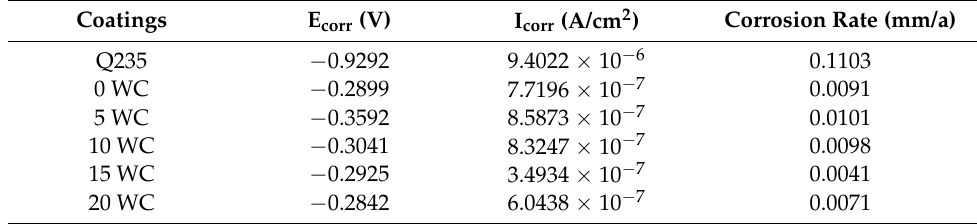
Figure 8. ( a ) Polarization curve; ( b ) AC impedance; ( c ) Bode diagram; ( d ) AC impedance equivalent circuit diagram. Table 7. Polarization curve fitting parameters of different